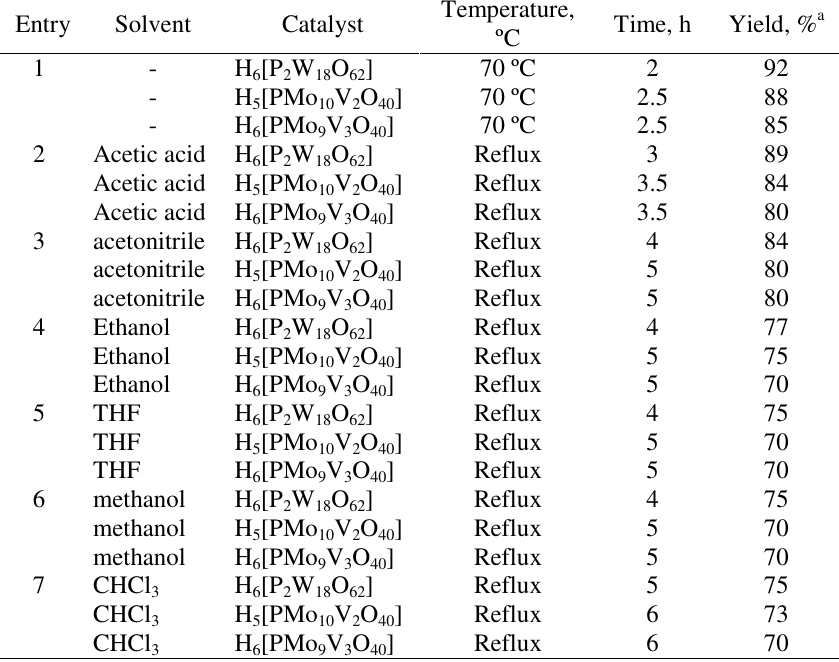
Table 3 . Synthesis of 3a in the presence of different solvents.